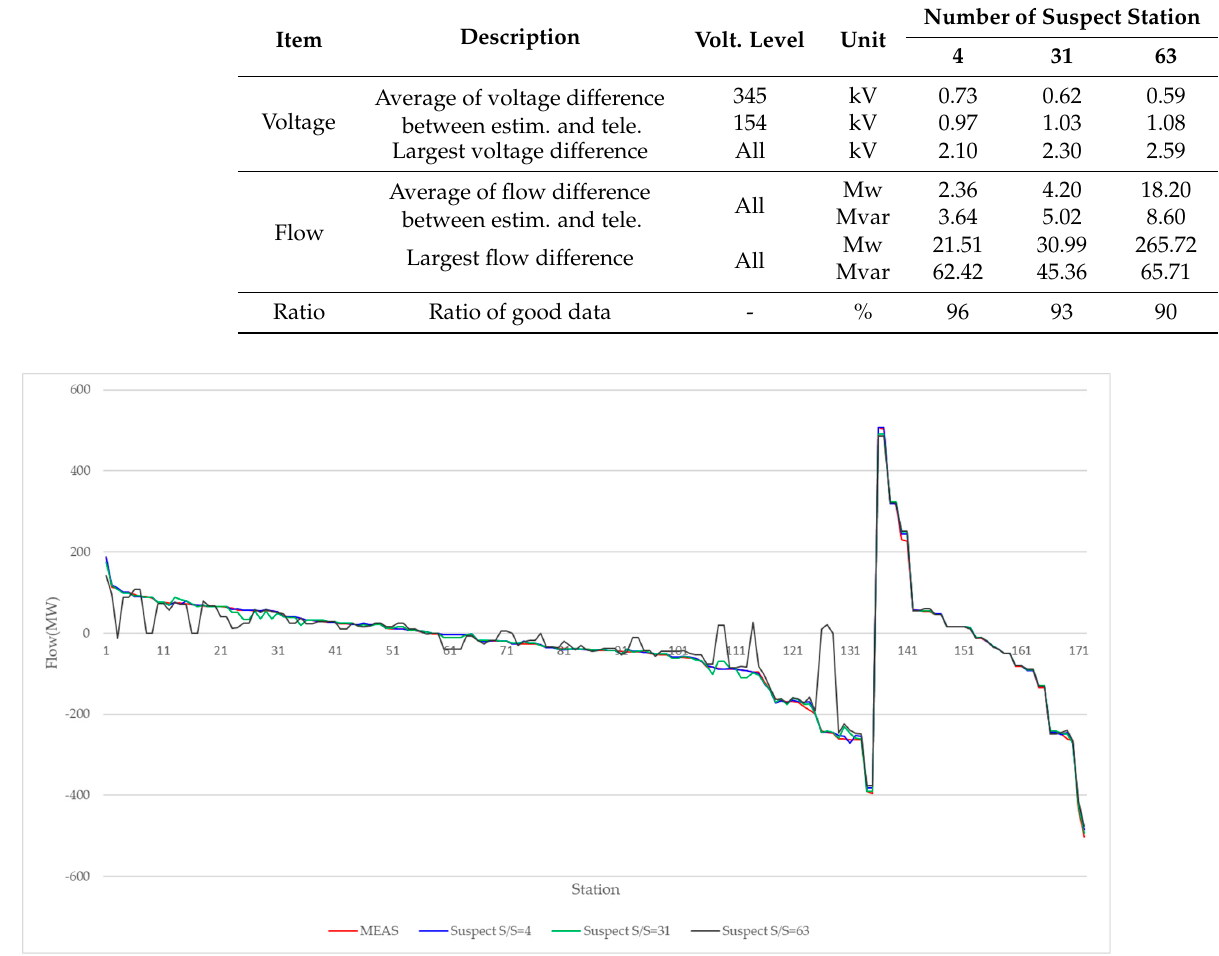
Table 20. Comparative results for severe events.